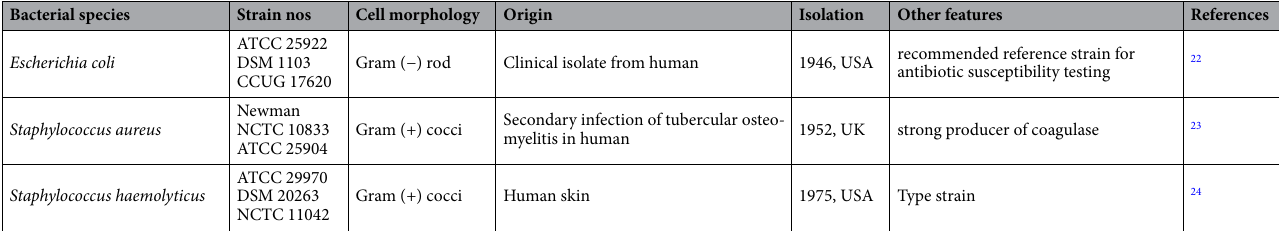
Table 3. Bacterial strains of opportunistic human pathogens used in this study. ATCC—American Type Culture Collection (Manassas, USA); NCTC—National Collection of Type Cultures (Porton Down,